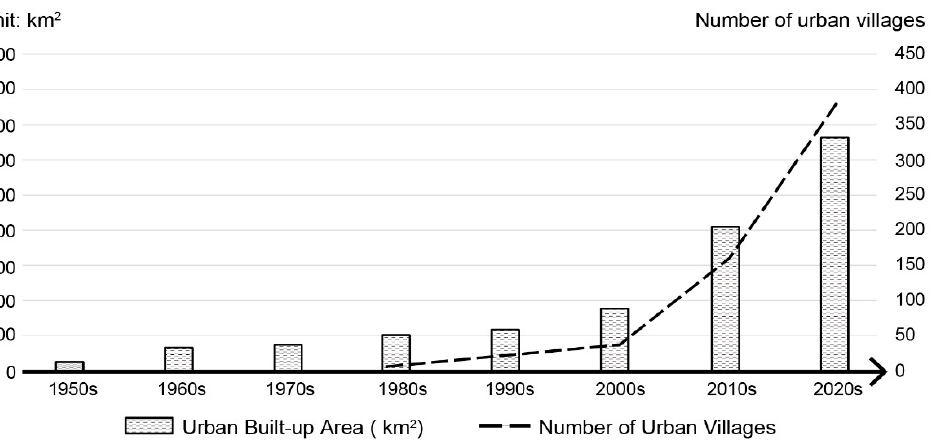
Figure 3. Built-up area and number of urban villages in Hangzhou urban district form the 1950s to the 2020s.